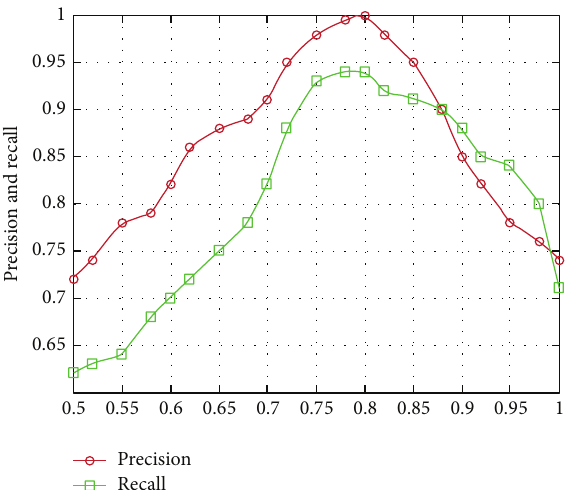
Figure 7: Precision and recall with variety of the threshold 𝛽 2 .